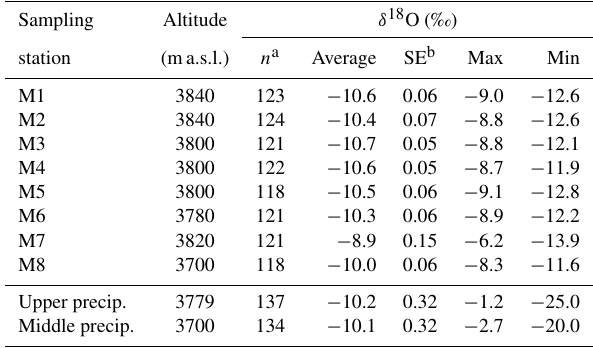
Table 4. Statistics of the δ 18 O isotopic composition in precipitation and streamflow used as input data for the MTT modeling.